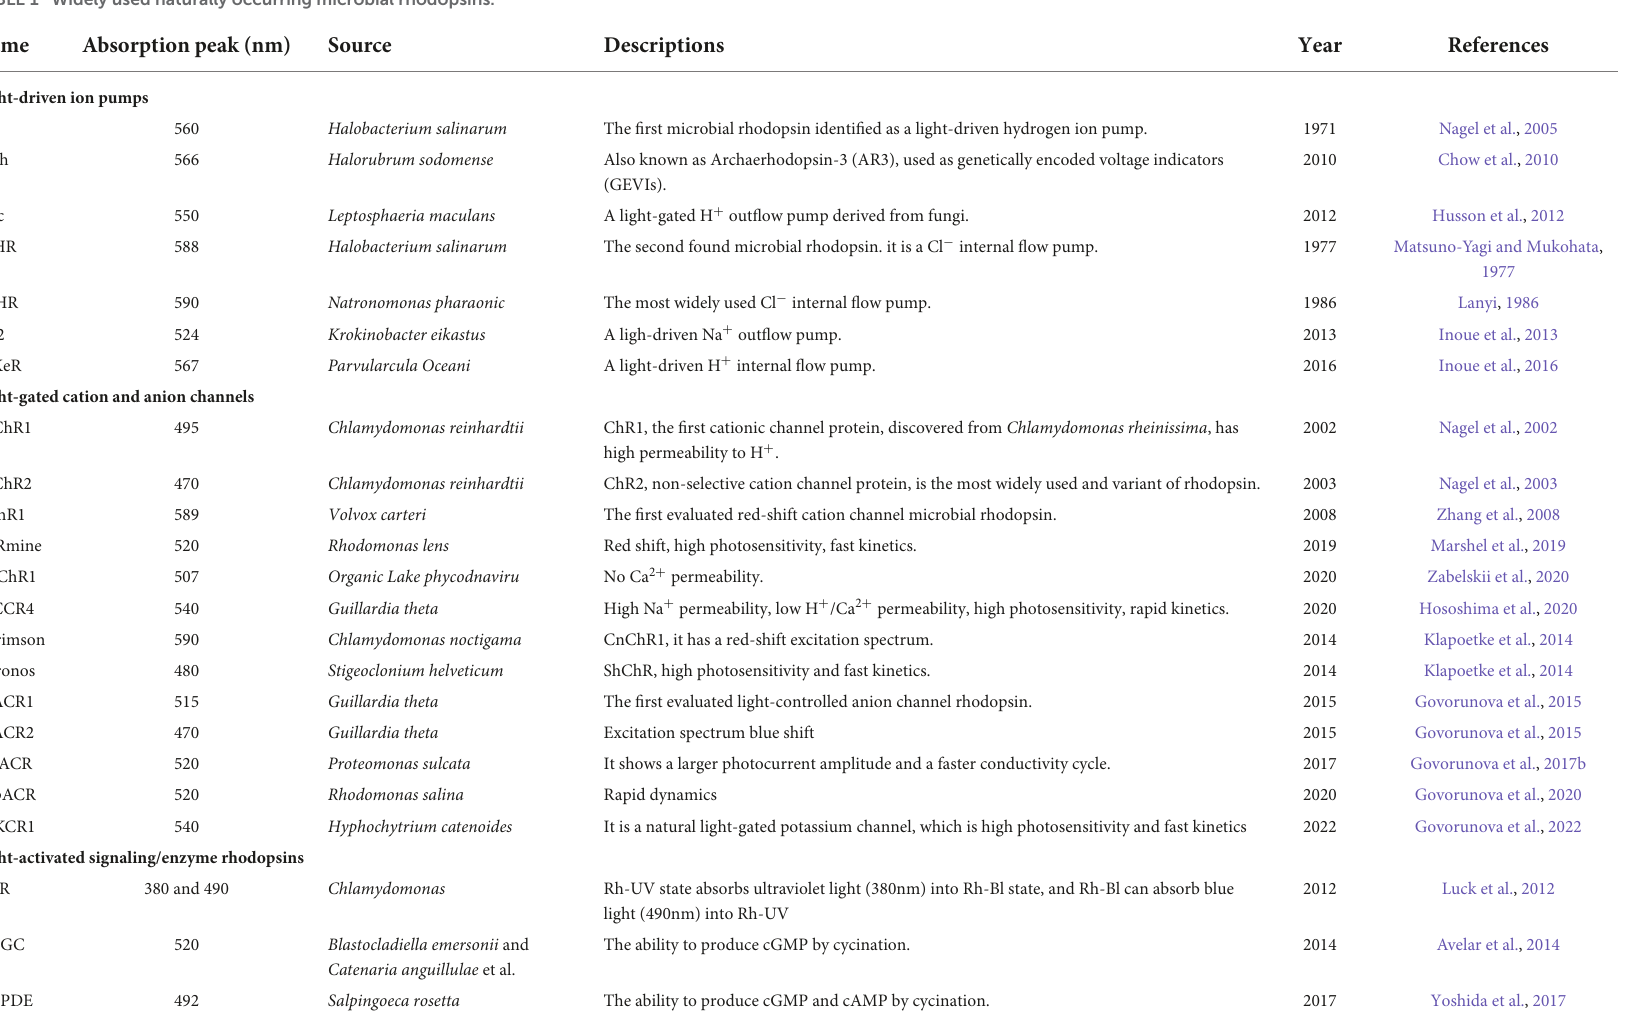
TABLE 1 Widely used naturally occurring microbial